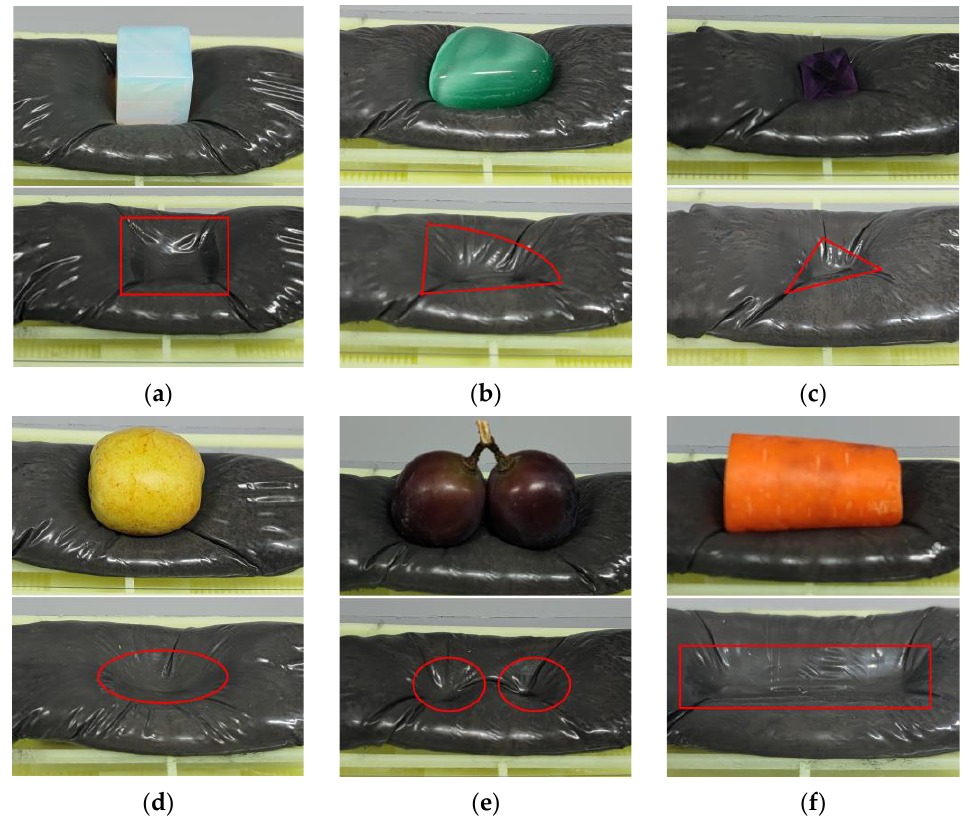
Figure 13. Adaptivity of different objects. ( a ) Cube Crystal. ( b ) Irregular Crystal. ( c ) Polyhedral Crystal. ( d ) Jujube. ( e ) Grape. ( f ) Carrot. The concave pits are marked with red lines.